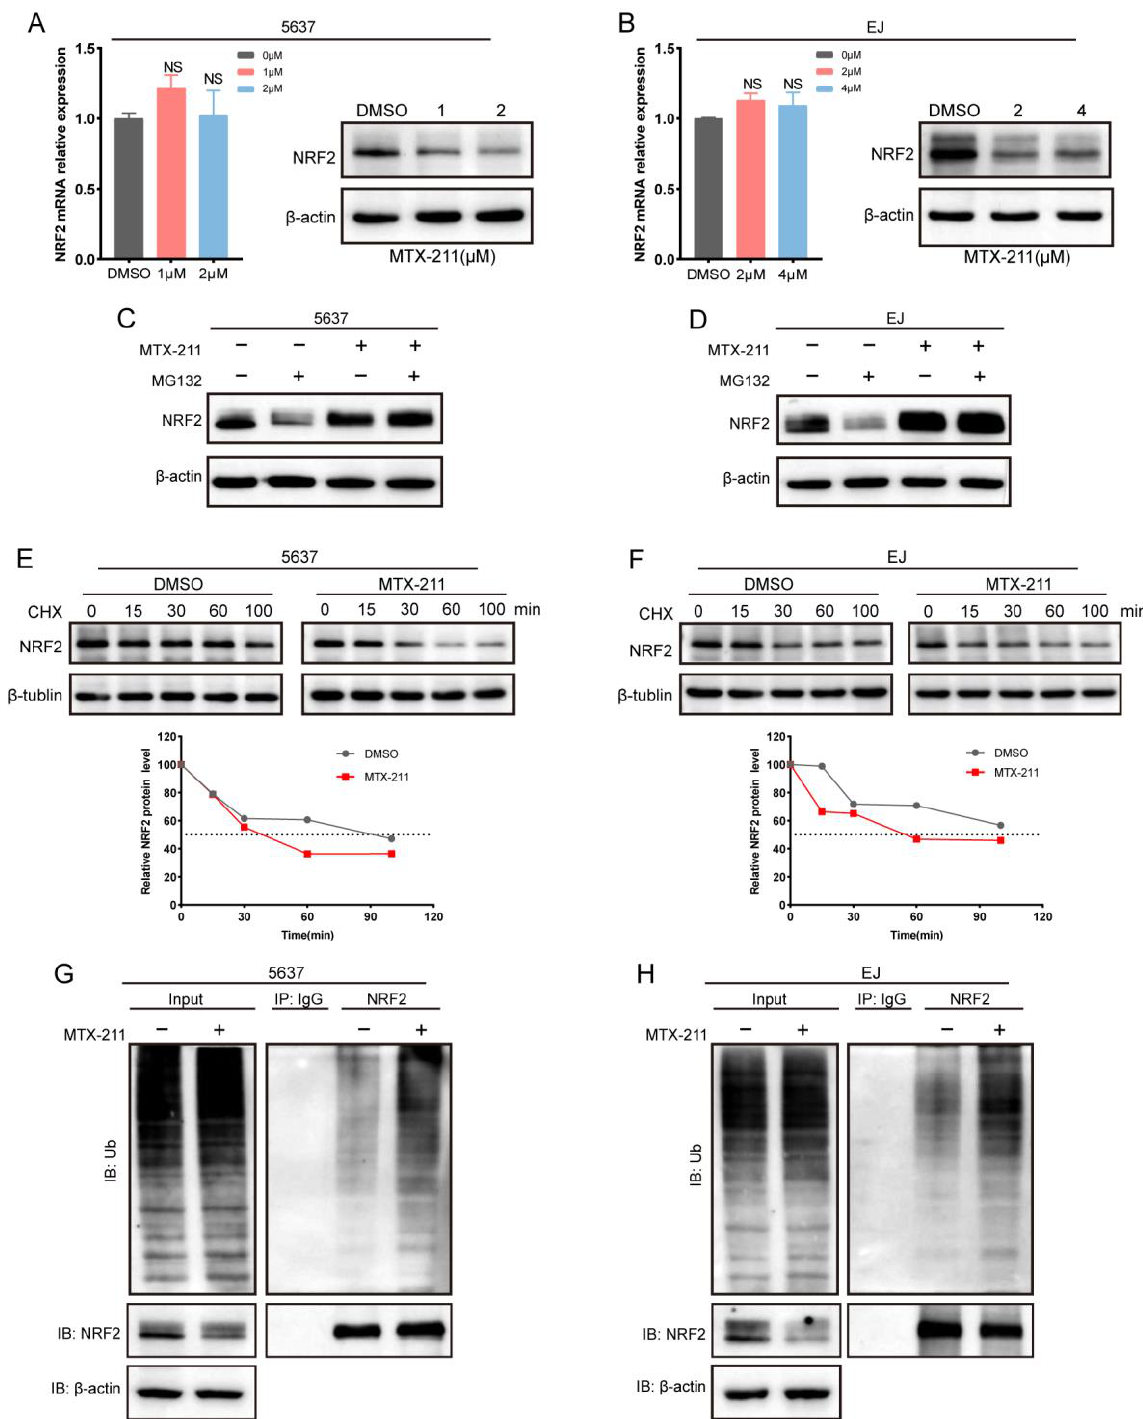
Figure 4. MTX-211 promotes NRF2 protein ubiquitinated degradation. ( A , B ) The effect of treatment with different concentrations of MTX-211 for 48 h on the mRNA and protein expression levels of NRF2 in 5637 and EJ cells. ( C , D ) Western blotting analysis of NRF2 in 5637 and EJ cells treated with DMSO or MTX-211 for 48 h, followed by treatment with or without MG132 (10 µ M) for 4 h. ( E , F ) Following 48 h treatment with MTX-211 or DMSO, 5637 and EJ were harvested at the indicated time after treatment with cycloheximide (CHX: 20 µ g/mL). Immunoblot of NRF2 was quantified. ( G , H ) The ubiquitination level of NRF2 in 5637 and EJ cells treated with MTX-211 for 48 h. IP: immunoprecipitation, NS: